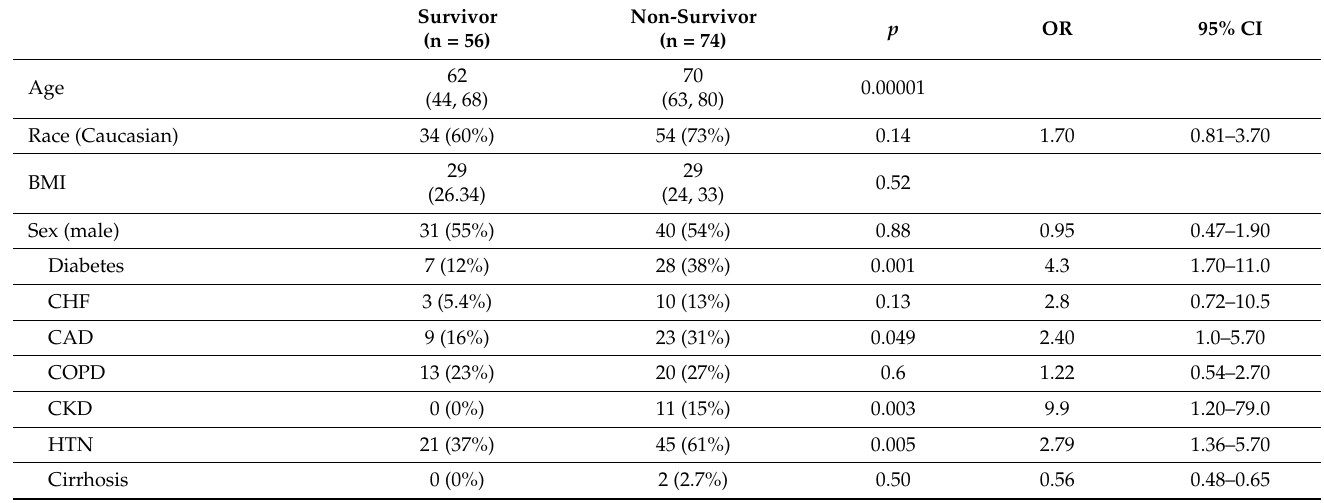
Table 7. Risk factors for mortality among COVID-19 ICU patients without